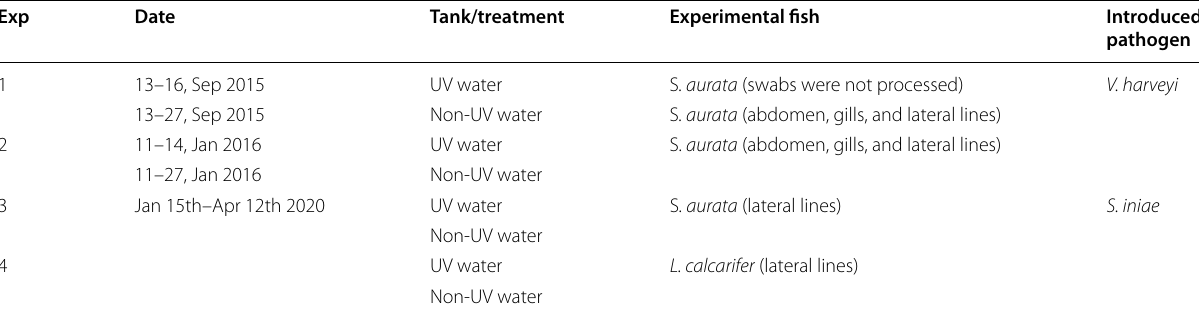
Table 1 Experimental design showing different treatments and sampling